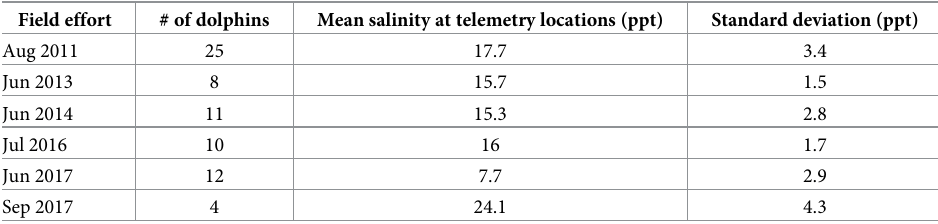
Table 1. Estimated mean salinity for dolphin telemetry locations by field effort. ppt = parts per thousand. Field